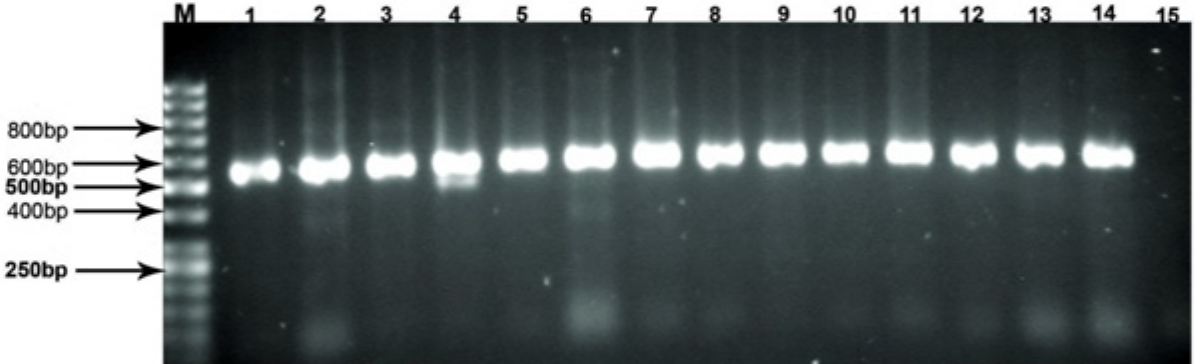
Figure 1. Agarose gel (1.5%) electrophoresis results of the PCR assay to detect a 548 bp fragment of the cpb2 gene in C. perfringens . Lane M: size marker (GeneRuler 50 bp DNA Ladder, Fermentas); lane 1: positive control for cpb2 gene (CIP 60.61); lanes 2 to 14: cpb2 -positive C. perfringens isolates from healthy and diseased chickens; lane 15: negative control (ATCC